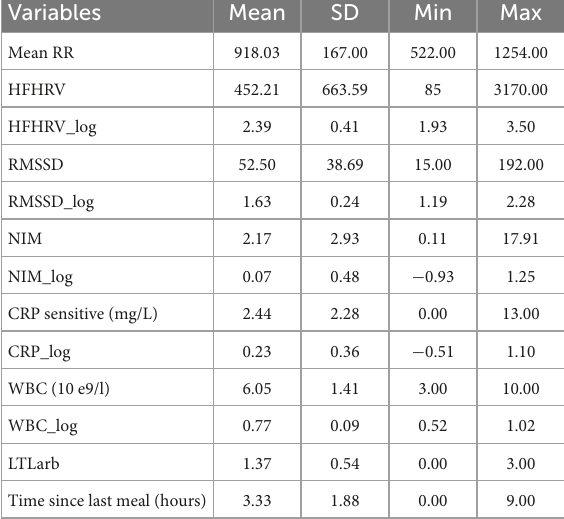
TABLE 2 Descriptive statistics ( N = 131).